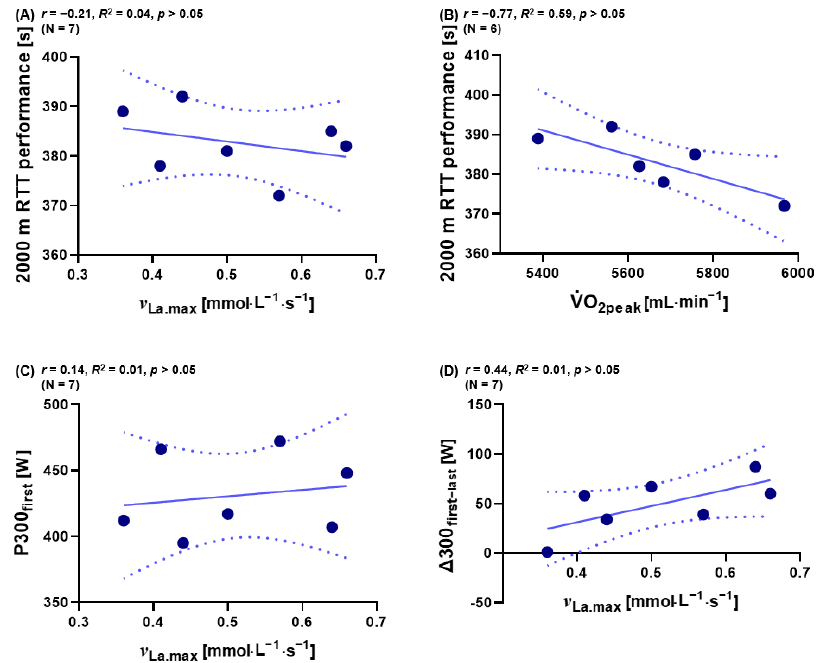
Figure 6. Relations between ( A ) 2000 m RTT performance and ν La.max ( n = 7), between ( B ) 2000 m RTT performance and O 2peak ( n = 6), ( C ) between P300 fist during 2000 m RTT performance and ν La.max ( n = 7), and between ( D ) ∆ 300 first − last of the 2000 m RTT and ν La.max ( n = 7). Dotted lines: 95% confidence interval, straight line: strength of the linear relationship between two variables.